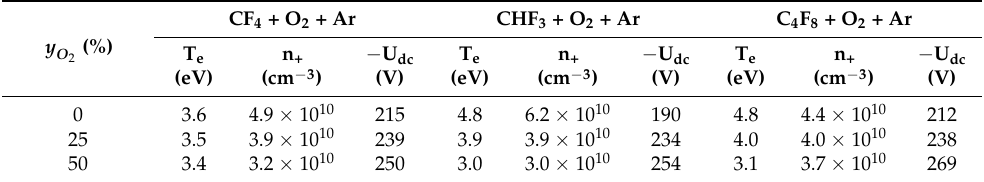
Table 3. Electron- and ion-related plasma parameters in 50% CF 4 + O 2 + Ar, 50% CHF 3 + O 2 + Ar and 50% C 4 F 8 + O 2 + Ar plasmas at p = 6 mTorr, W = 700 W and W dc = 200 W.